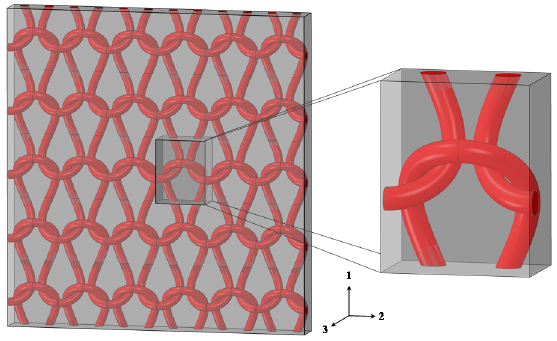
Figure 3. The single-layer weft-knitted composite and its RVE.